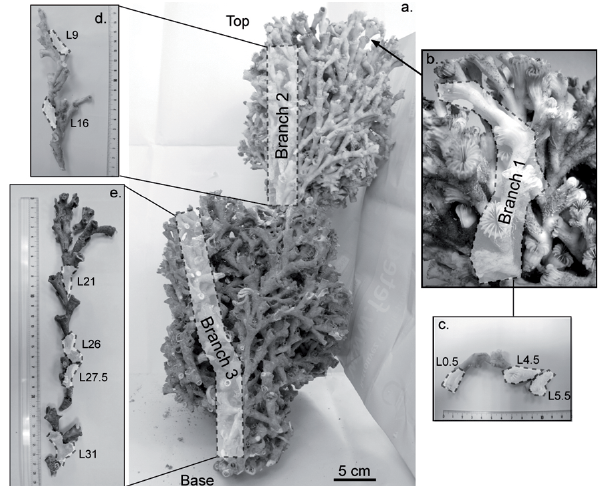
Fig. 3. (a) Photograph of a Lophelia pertusa specimen with the identification of branch 2 and 3, (b) location and identification of branch 1 in the upper part of the coral. Location of samples ana- lyzed for 210 Pb- 226 Ra chronology on extracted branch 1 (c) , branch 2 (d) and branch 3 (e)